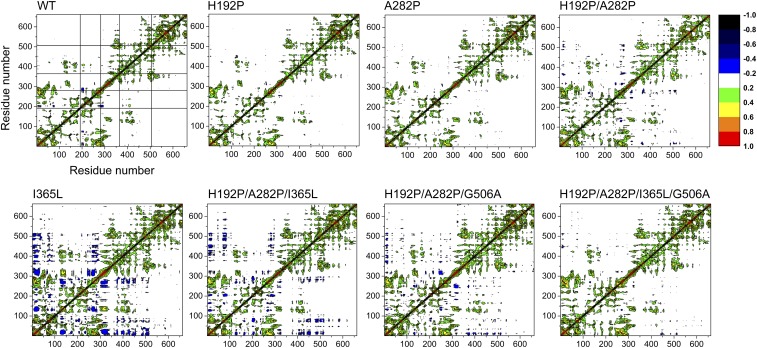
Dynamics cross-correlation map for the Cα atom pairs within monomers of TK WT and stable variants. Correlation coefficient (Cij) was shown as different colors. Cij with values from 0 to 1 represents positive correlations, whereas Cij with values from −1 to 0 represents negative correlations. Mutated sites are marked for WT with horizontal and vertical lines.